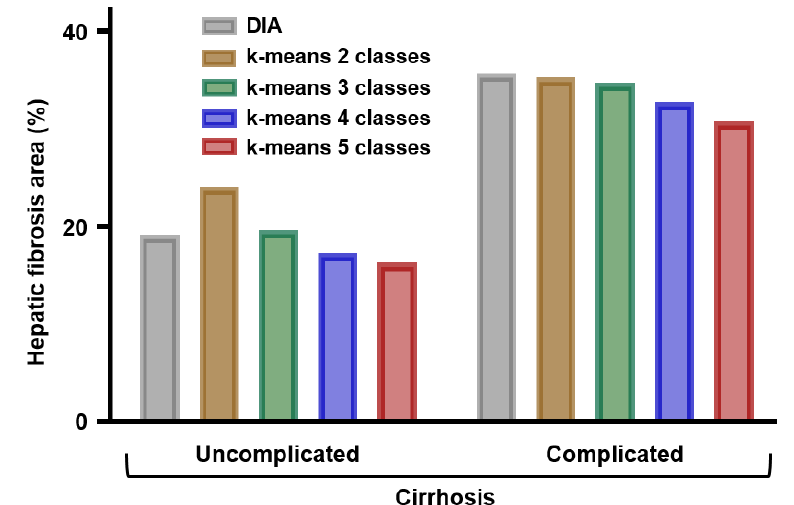
Figure 4. Percentages of fibrosis area in samples from uncomplicated ( n = 5) and complicated cirrhosis ( n = 5) as measured by digital image analysis (DIA) of histological sections or by k-means clustering of FTIR spectral images in 2, 3, 4, and 5 classes.